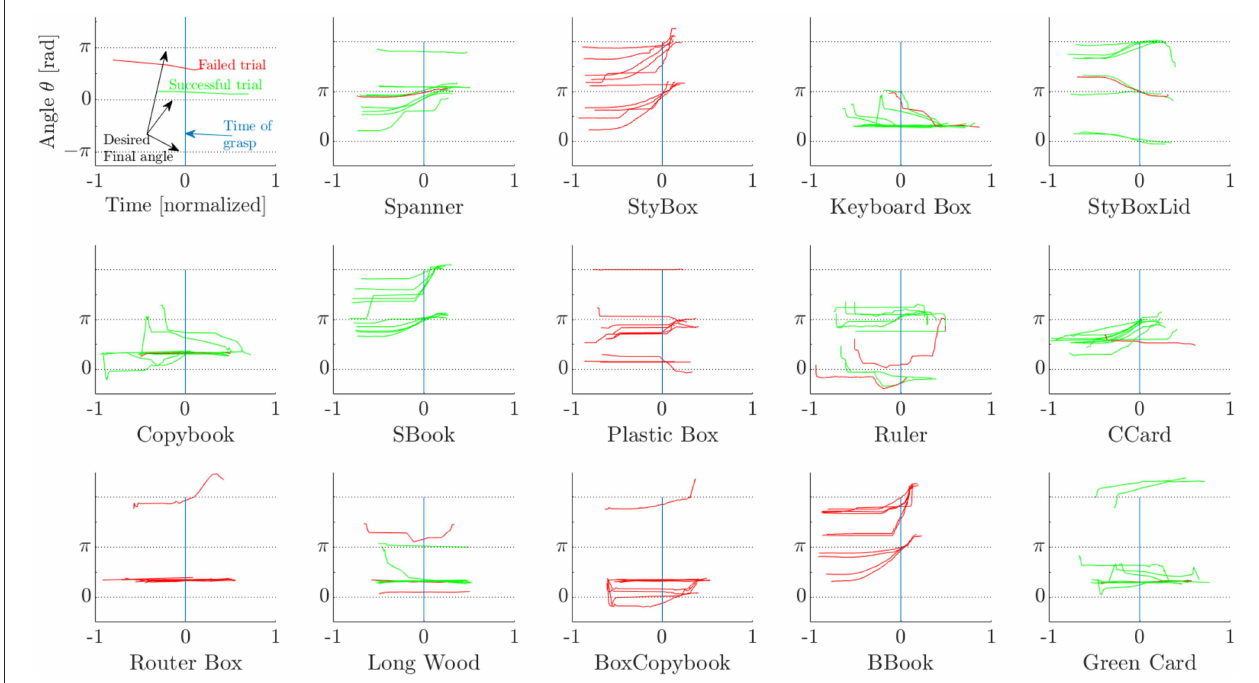
FIGURE 10 | Strategy 1: object orientation angle trajectory for each object and trial. (Top left) Symbol explanation.